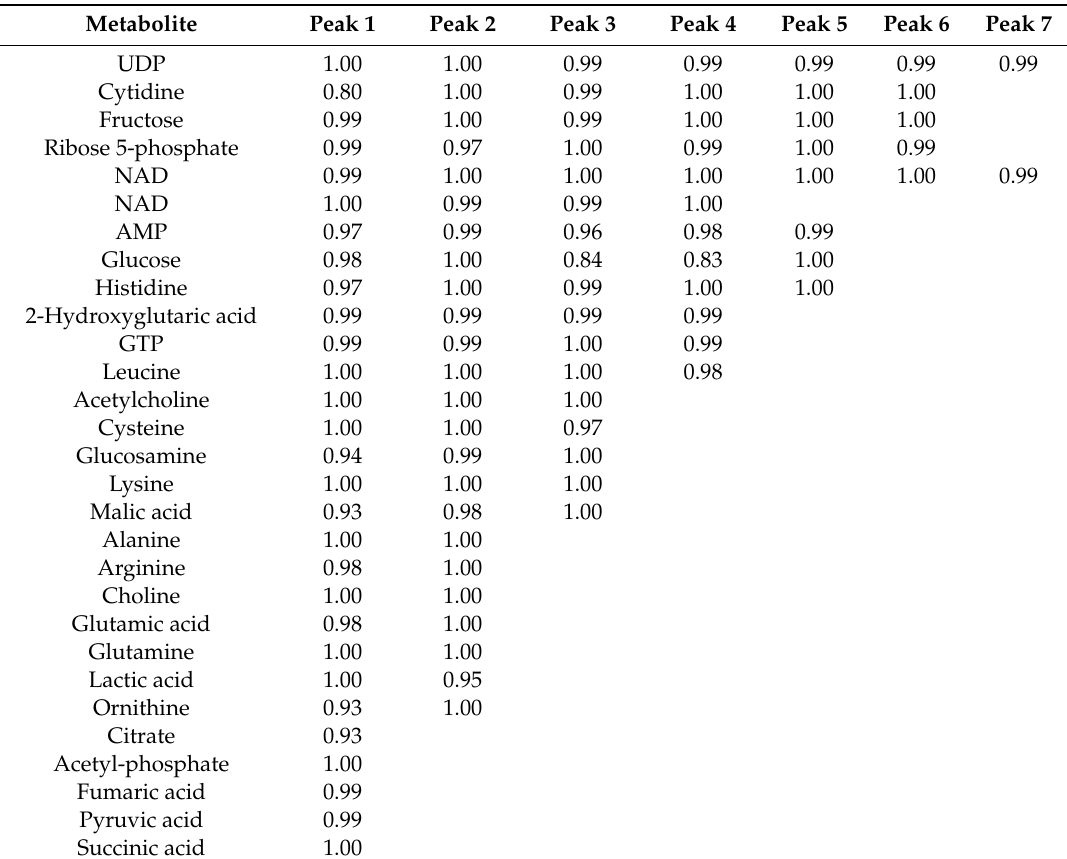
Table 1. Correlation coe ffi cient ( R 2 ) for measured metabolite